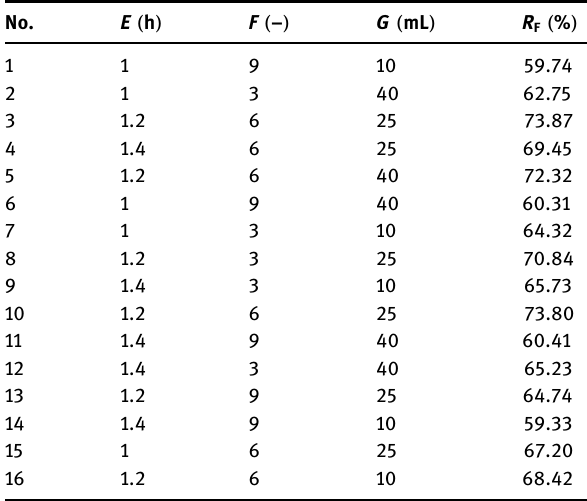
Table 4: Experimental design and